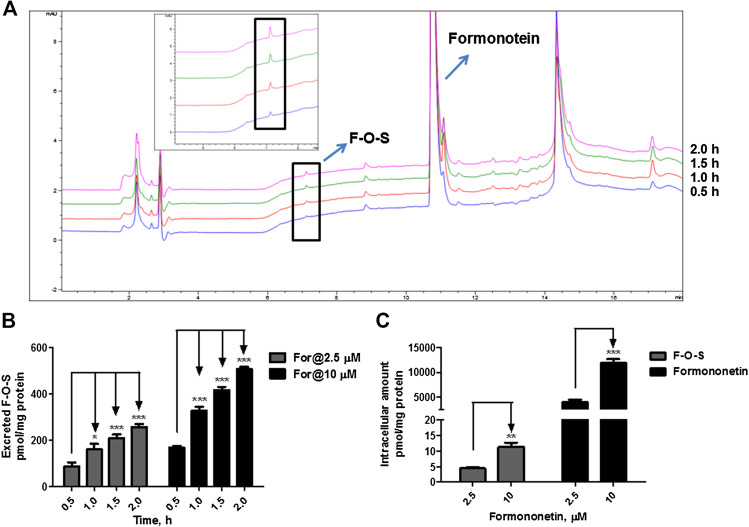
Disposition of formononetin in HEK-SULT1A3 cells at different loading doses. (A) Representative HPLC chromatograms showing that formononetin sulfate (F-O-S) was generated after incubation with HEK-SULT1A3 cells at different time points and excreted into extracellular medium. (B) Excretion rates of formononetin sulfate (F-O-S) at dose of 2.5 μM and 10 μM, respectively. (C) Intracellular amounts of formononetin and F-O-S at 2 h after incubation under different loading doses. *p < 0.05, **p < 0.01, ***p < 0.001 compared with control. Each data point was shown as mean ± SD (n = 3).